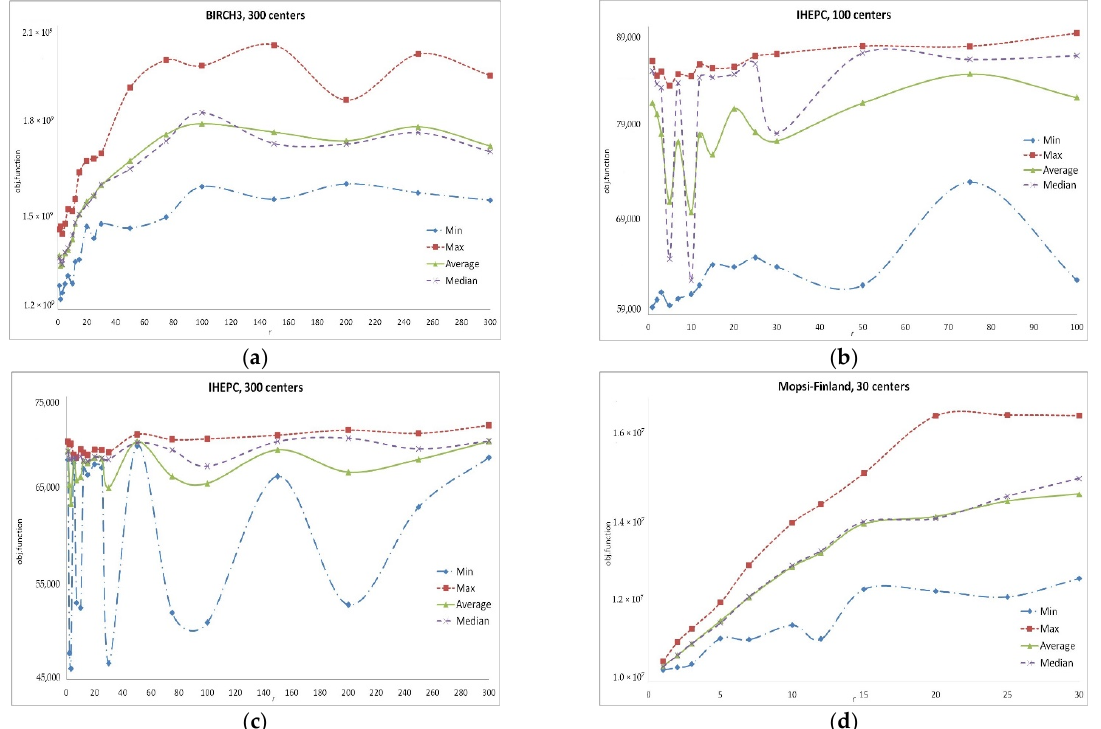
Figure 1. Comparative results of the search in SWAP r neighborhoods. Dependence of the result (1) on r : ( a ) BIRCH3 dataset, search for 300 centers, 100,000 data vectors, time limitation 10 s; ( b , c ) IHEPC dataset, search for 100 and 300 centers, respectively, 2,075,259 data vectors, time limitation 300 s; ( d ) Mopsi-Finland dataset, search for 30 centers, 13,467 data vectors, time limitation 5 s.